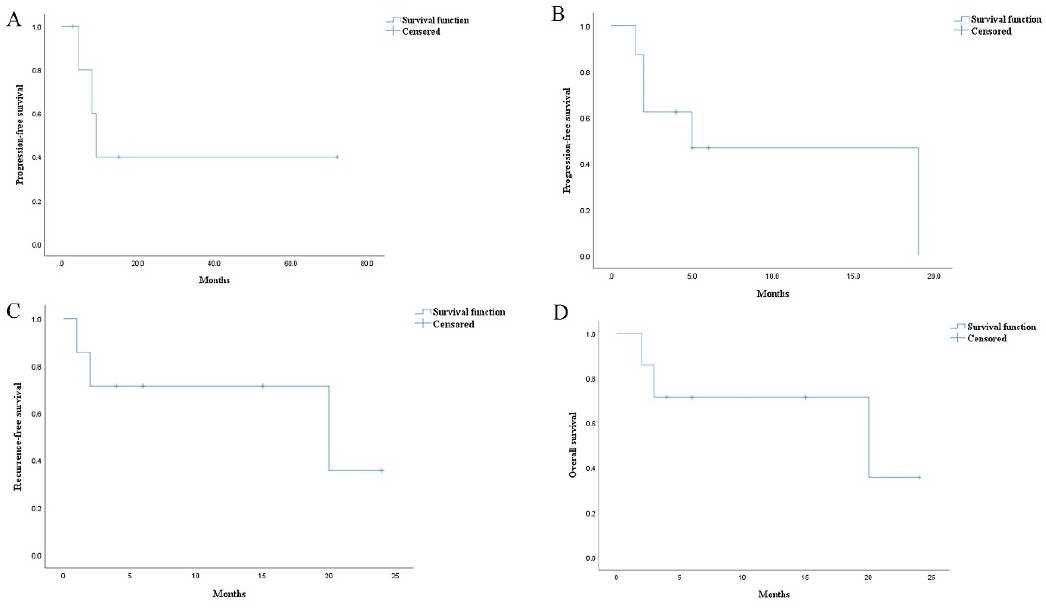
Figure 2. Kaplan–Meier estimates of survival: ( A ) progression-free survival in the 6 patients treated by radiotherapy without any continued TKIs; ( B ) progression-free survival in the 8 patients treated by radiotherapy with previously resistant TKIs; ( C ) recurrence-free survival in the 7 patients treated by radiotherapy without continued TKIs after surgery; ( D ) overall survival in the 7 patients treated by radiotherapy without continued TKIs after surgery.